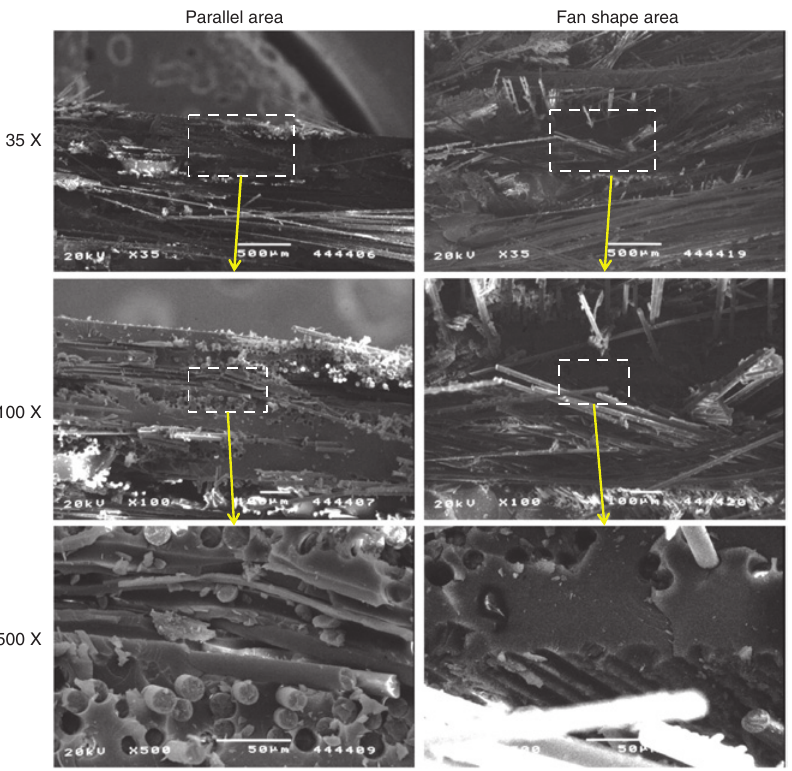
Figure 10 Fracture of notched specimen in parallel area (fiber fractures) and fan shape area (pulling out or shearing fracture of glass